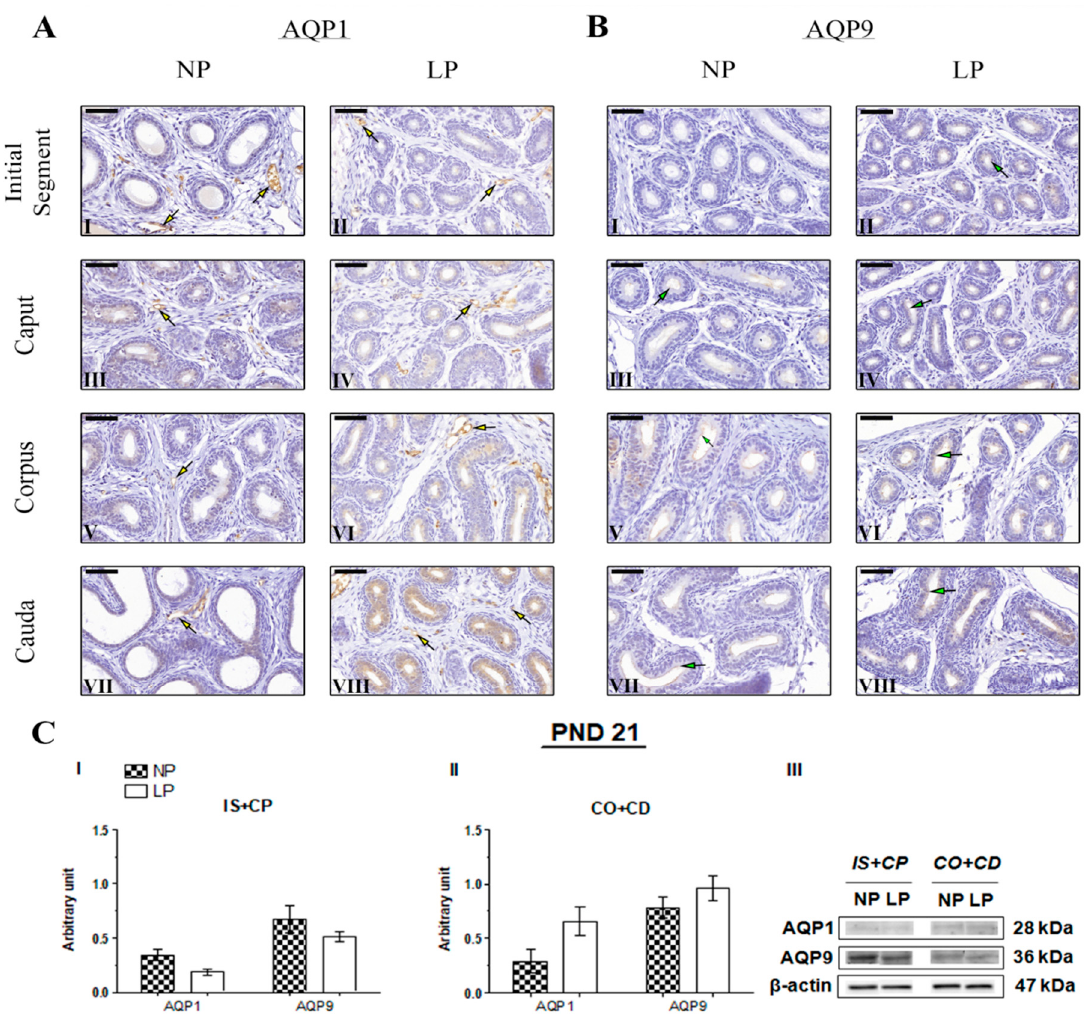
Figure 4. Expression and immunolocalization of aquaporins (AQP)1 and AQP9 in the epididymis of 21-day-old animals. ( A ) Immunoreactivity for AQP1 in endothelial cells of vascular channels in the initial segment ( I and II ), caput ( III and IV ), corpus ( V and VI ), and cauda ( VII and VIII ) of NP and LP animals (yellow arrows). ( B ) Immunoreactivity for AQP9 in the stereocilia of epididymis principal cells in the initial segment ( I and II ), caput ( III and IV ), corpus ( V and VI ), and cauda ( VII and VIII ) of NP and LP animals (green arrows). Bar = 50 µ m. ( C ) Extracts obtained from individual animals were used for a densitometry analysis of the levels of proteins in the initial segment plus caput ( I ) and corpus plus cauda ( II ) following normalization to the housekeeping protein β -actin. Representative blots showing the levels of the AQP1, AQP9 and β -actin proteins ( III , right panel). Data are presented as means ± S.E.M. and were analyzed using the Mann-Whitney test.